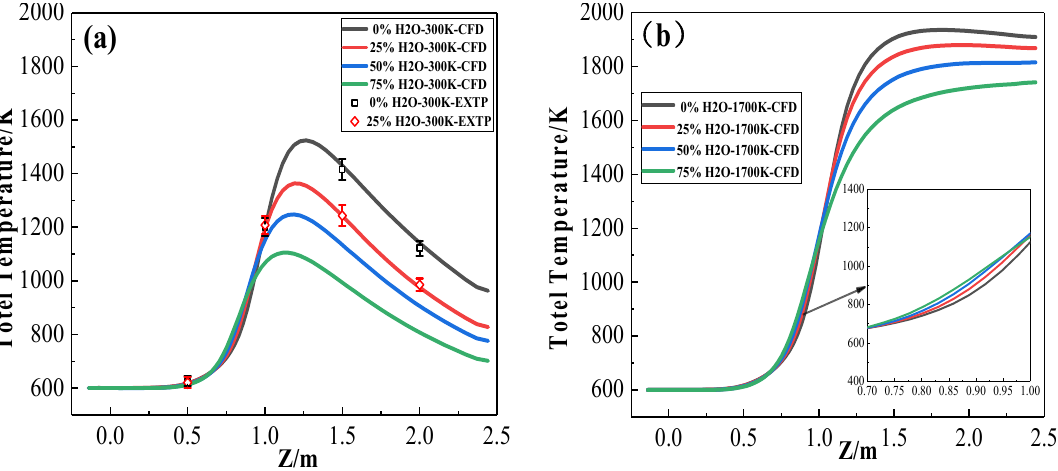
Figure 9. The total temperature distribution of the H 2 O and O 2 mixed injection jet along the axis. ( a ) The temperature distribution of the mixed injection jet with different components at an ambient temperature of 300 K. ( b ) The temperature distribution of the mixed injection jet with different components at an ambient temperature of 1700 K.